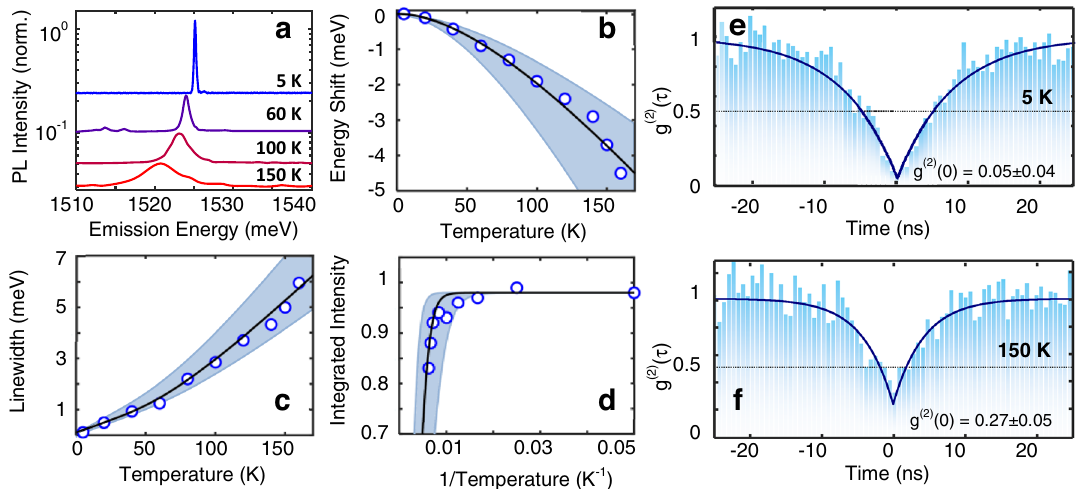
Fig. 5 Statistics of single-photon emission up to 150K. a Evolution of the PL spectrum as function of the temperature. b Redshift of the SPE line with temperature increase due to the reduction of the bandgap following Varshni ’ s empirical relationship. c Homogenous linewidth broadening due to the increase of temperature. d Arhenious plot of the integrated intensity. The PL peak starts to quench around 150 K and reaches e − 1 at 215 K. Shaded region in b , c , and d demonstrate the range of recorded parameters for an ensemble of emitters. Open circles demonstrate measured data for a single emitter in the ensemble and the solid black lines are theoretical fi t to the data. e Second-order correlation measurement g (2) at T = 5 K and f at 150 K exhibiting g 2 (0) < 0.3, evidencing that the single-photon nature persists up to our maximum measurement temperature of 150 K and likely persists beyond 200 K. Horizontal dashed lines represents the quantum limit of g (2) at